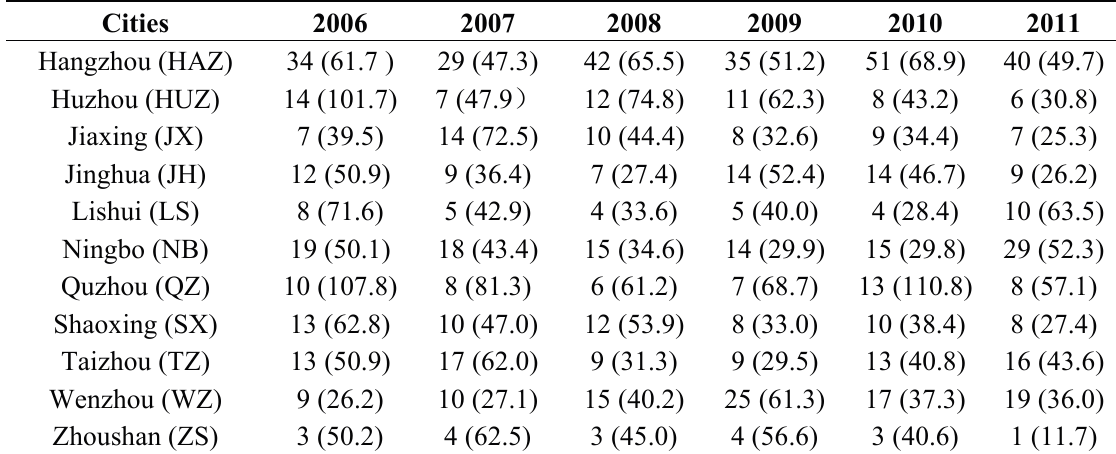
Table 1. The number of Tuberculosis (TB) patients among the Healthcare Workers (HCWs) in 11 prefectures of Zhejiang from 2006 to 2011 (number, annual notification rate: /100,000).